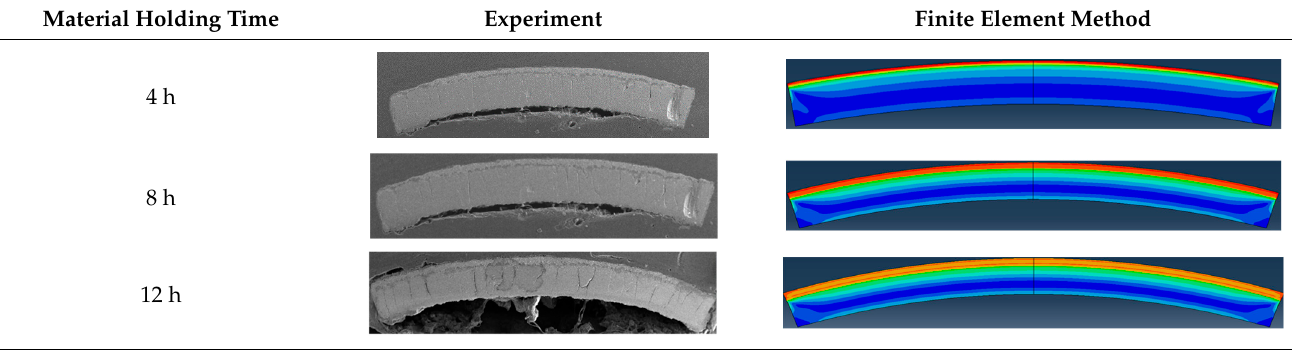
Table 2. Comparison of thermal buckle performance obtained via (left) experimental and (right) finite element methods. Material Holding Time